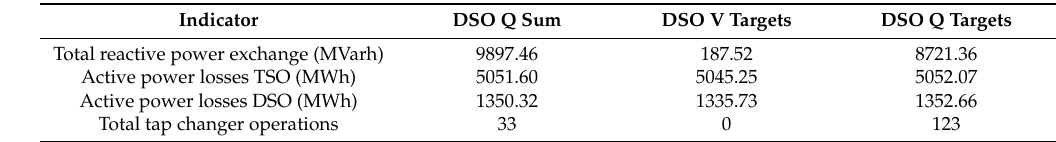
Table 4. Performance indicators of weekly setpoints comparison.